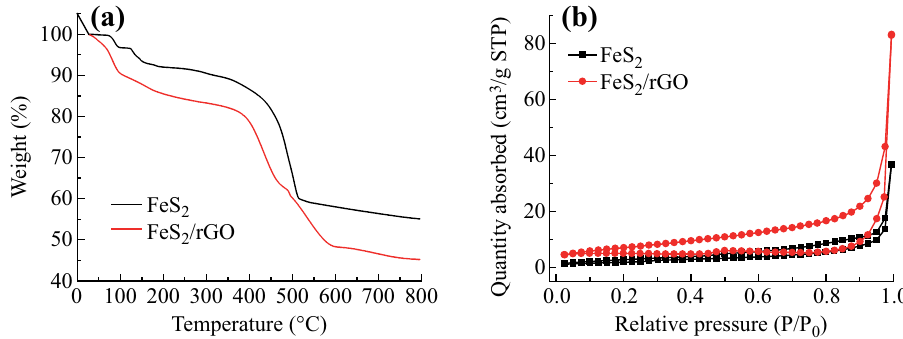
Fig. 3 a TG curves and b N 2 adsorption–desorption curves of FeS 2 and FeS 2 /rGO